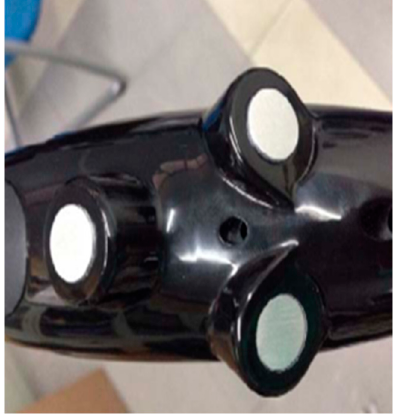
Figure 33. Replacement of three ultrasonic sensors on the cane [54].